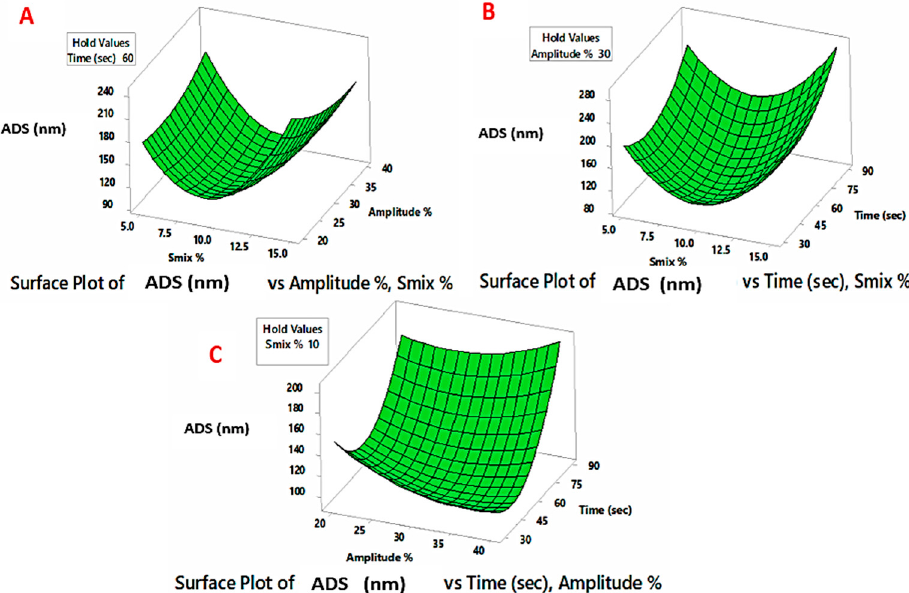
Figure 1. Diagrams of surface response demonstrating the impact of processing parameters on average droplet size (ADS). ( A ) Impact of % S mix and amplitude % on ADS; ( B ) Impact of % S mix and sonication time on ADS; ( C ) Impact of time of % amplitude and sonication time on ADS.